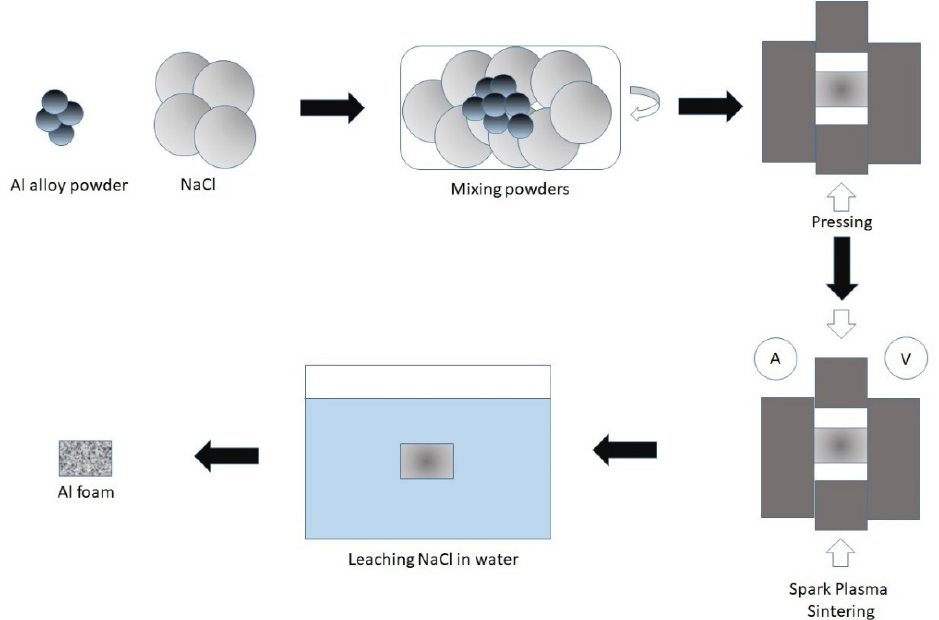
Figure 2. Schematic illustration of spark plasma sintering (SPS) method.